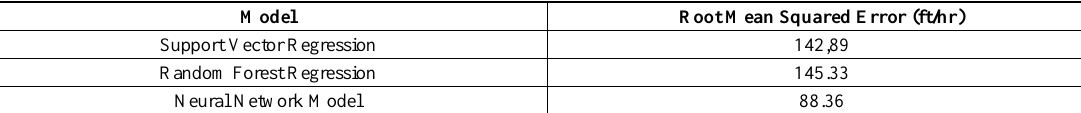
Figure 9. ROP prediction by support vector regressor and random forest regressor Table 5. Model performance